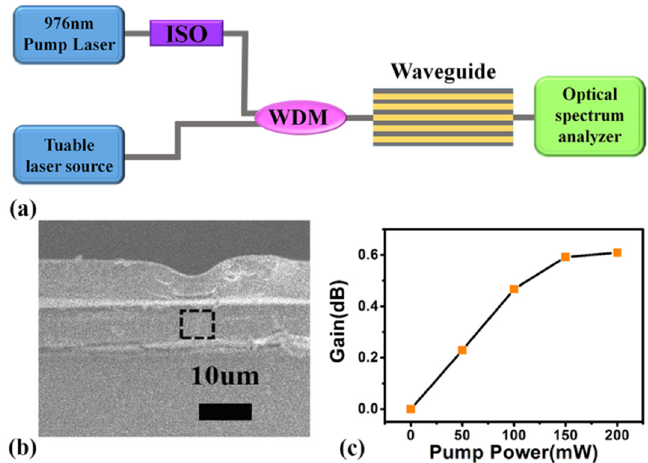
Figure 8. ( a ) Schematic illustration of measuring the optical gain of waveguide amplifiers. ( b ) SEM image of the KMnF 3 :18%Yb 3+ ,1%Er 3+ @KMnF 3 :2%Yb 3+ NPs doped with polymer waveguide. ( c ) The relative gain as a function of pump power (980 nm) with different input signal powers (1534 nm) in KMnF 3 :18%Yb 3+ ,1%Er 3+ @KMnF 3 :2%Yb 3+ NPs doped with polymer waveguide.